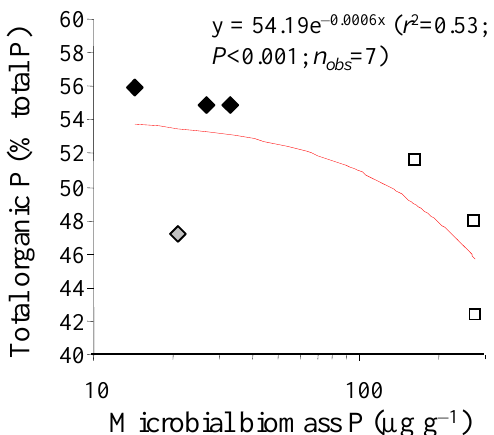
Fig. 4. Total organic P as a function of microbiological activity in- ferred by microbial biomass P and Al + Fe oxides. Squares, forest floor samples; diamond, surface mineral soils; open symbols, 20– 57µmol Al + Fe oxides g − 1 ; grey symbols, 105µmol Al + Fe ox- ides g − 1 ; black symbols, 142–150µmol Al + Fe oxides g − 1